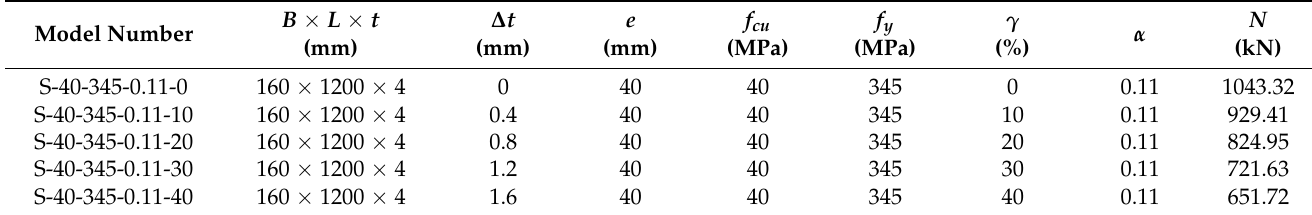
Table 3. Main design parameters of